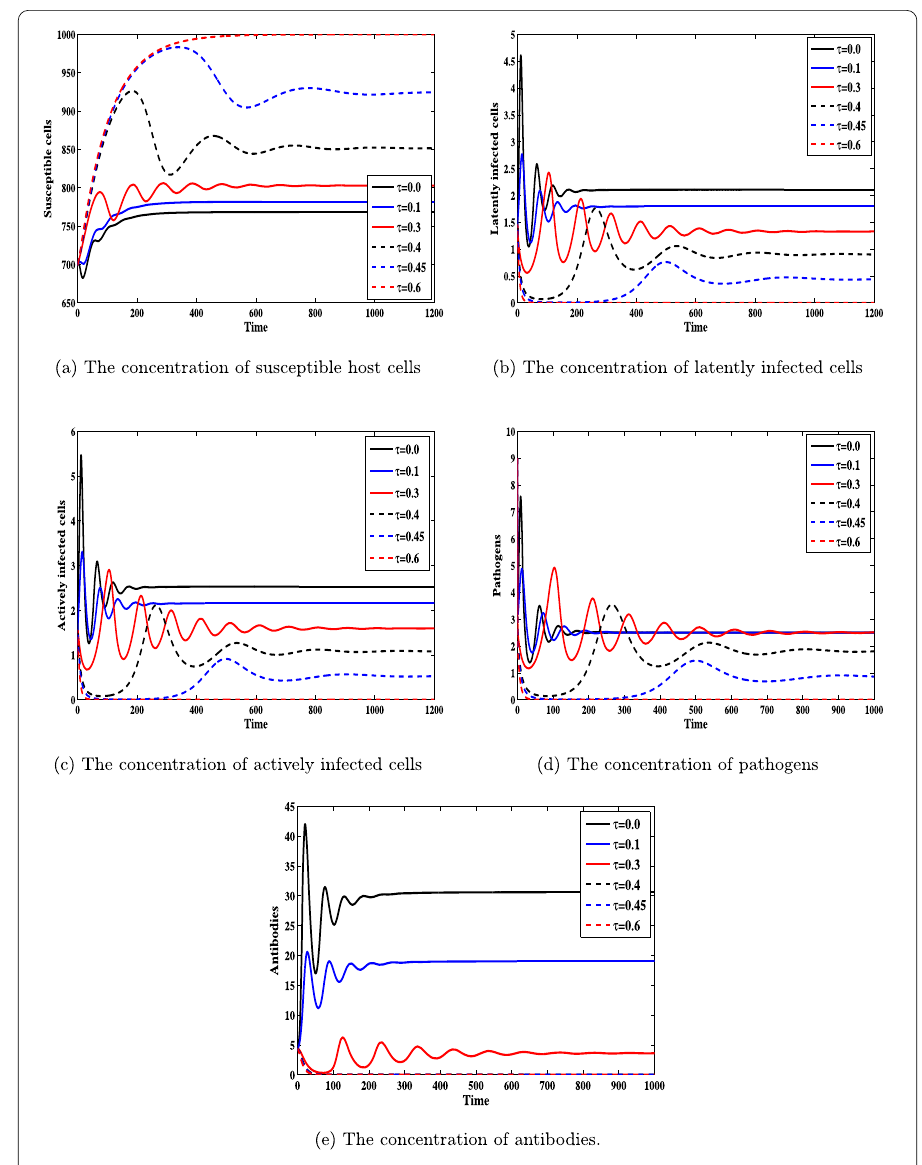
Figure 2 The simulation of trajectories of system (2) with different values of τ for Case (II)